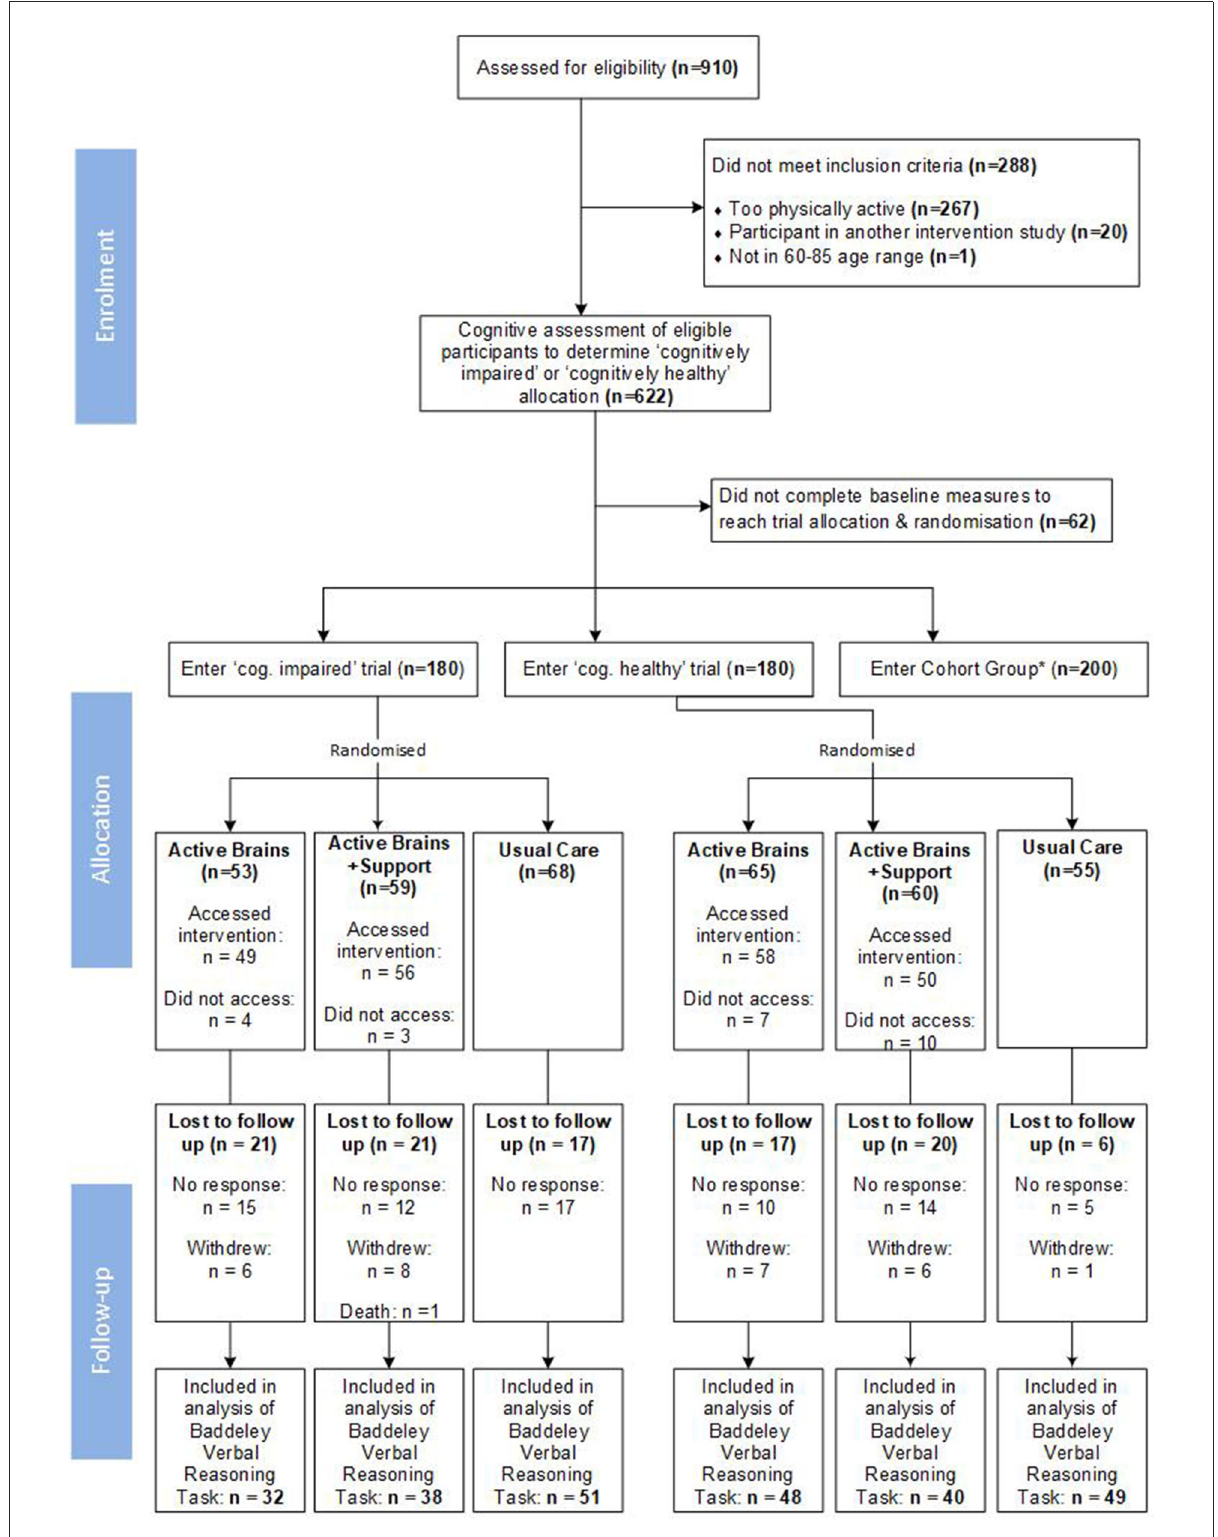
FIGURE1 Recruitment and retention into the parallel trials; *Cohort group data not presented within this